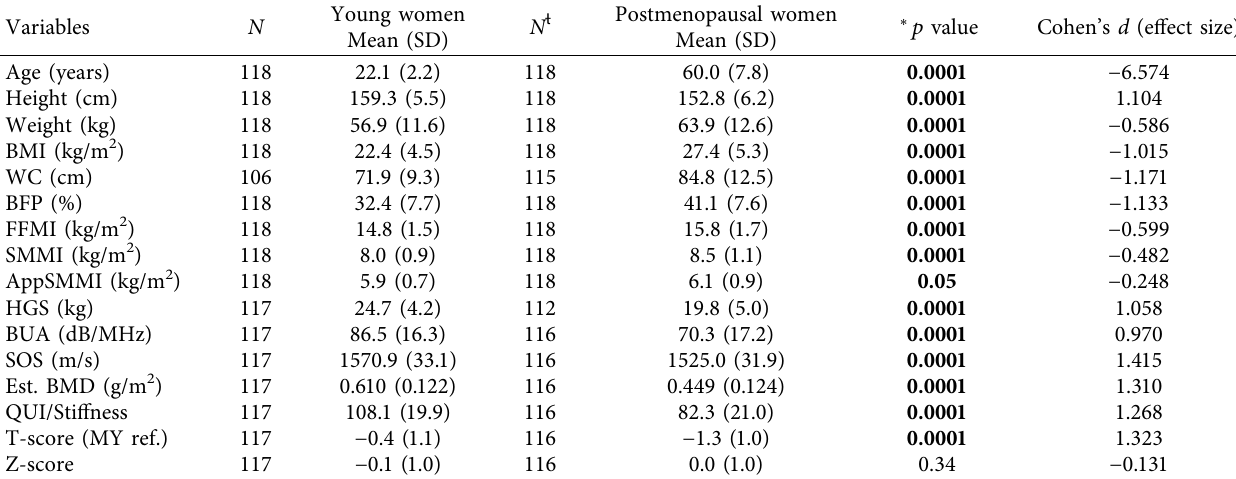
Table 2: Differences in characteristics: young versus postmenopausal women.